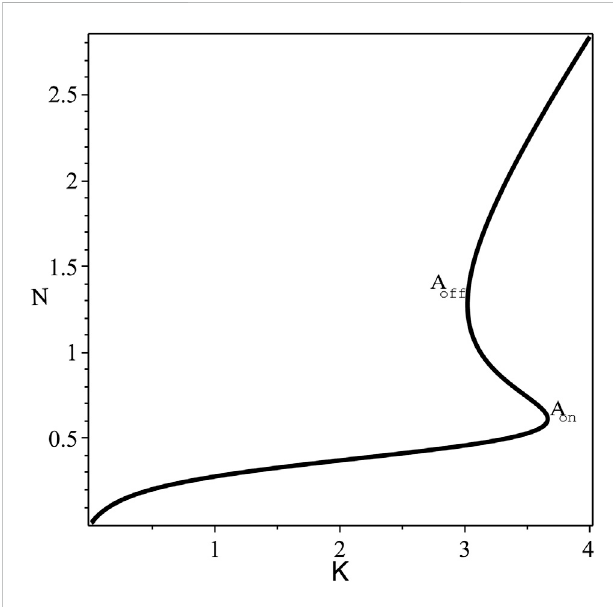
FIGURE 1 The steady state bistable curve of N against K , at fi xed values of the parameters F =0.85, B =0.5. The switching-on and -off points: A on =(3.6631,0.61299) and A off =(3.0199,1.2793).